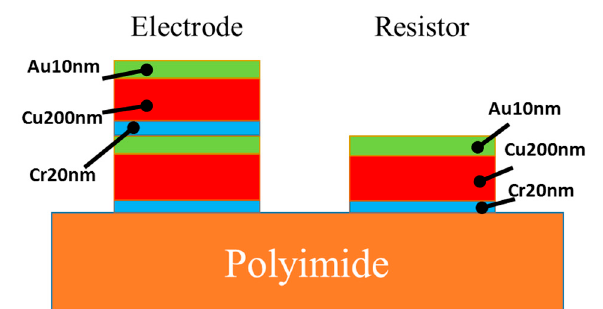
Figure 6. Metal layers on polyimide film.